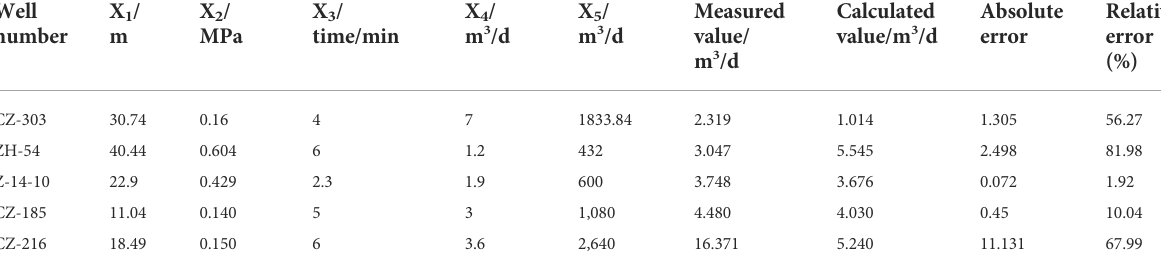
TABLE 5 Calculation results of methane emission model (the gas-liquid two-phase fl ow stage).